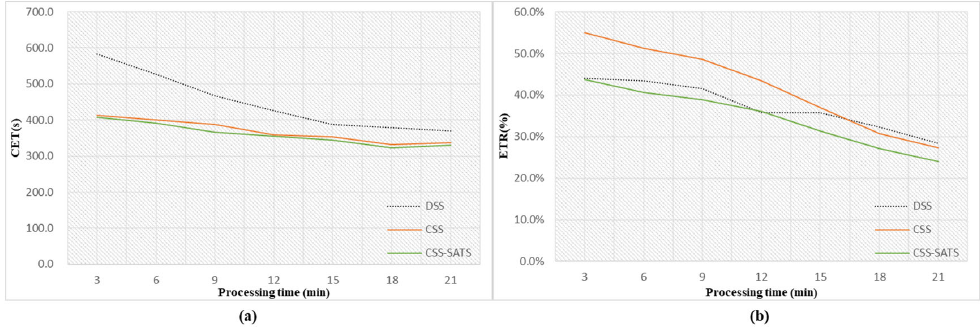
Fig. 13. The performance in CET (a) and ETR (b) in experiment